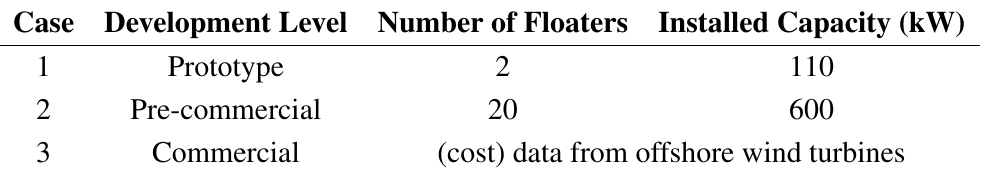
Table 1. Considered development stages of the Wavestar